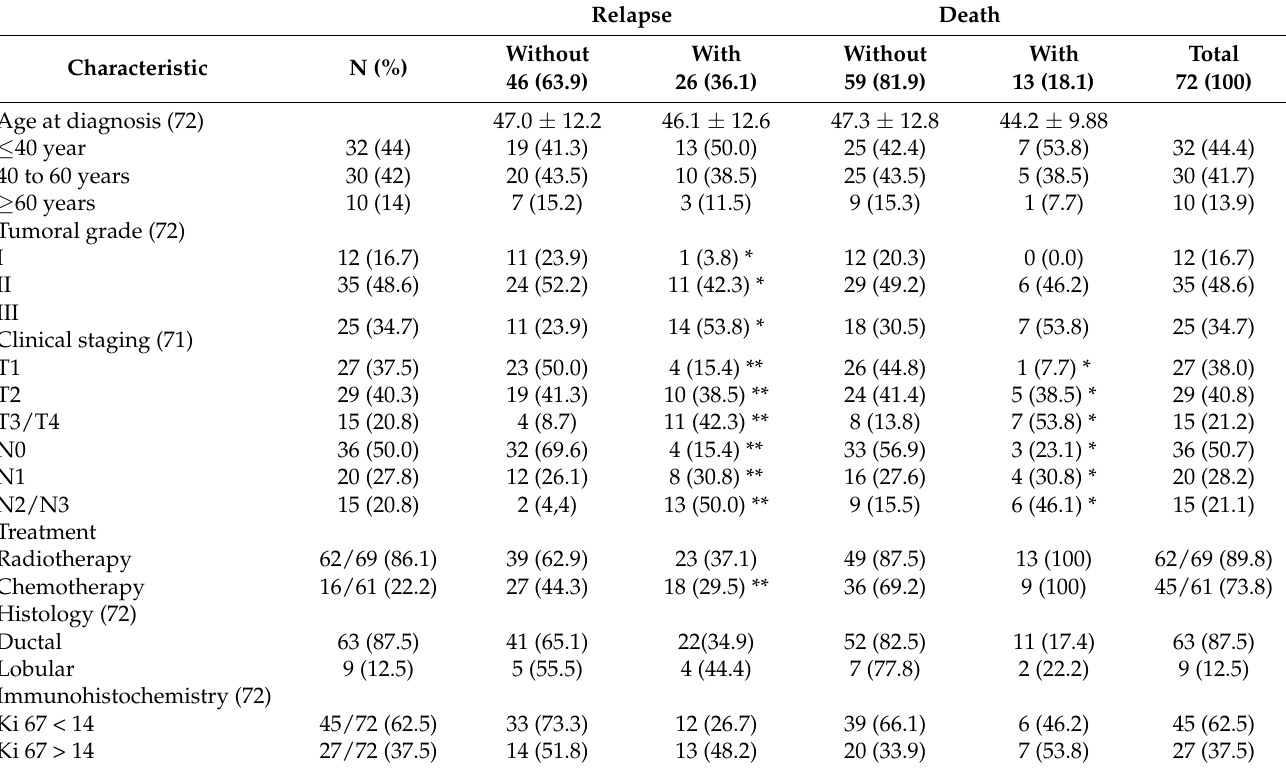
Table 1. Characterization of the patients according to relapse and death.